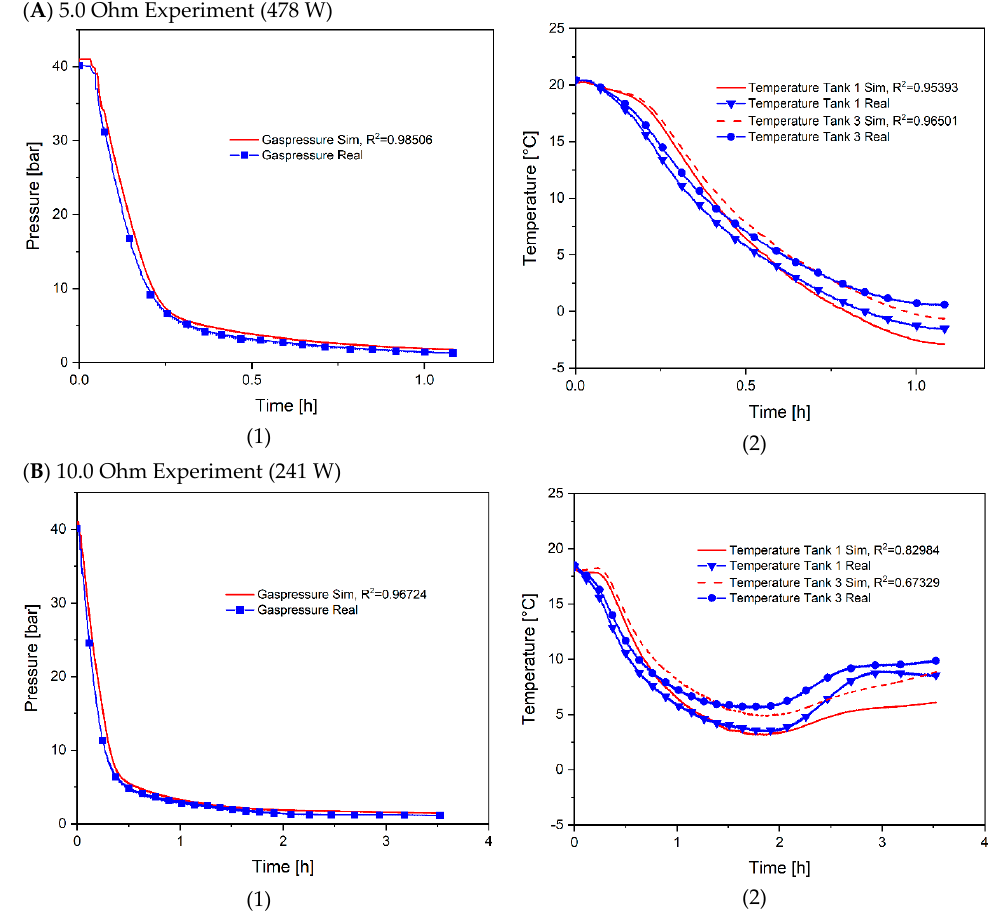
Figure 7. Simulated (Sim) and measured (Real) system pressure curves (1) and temperature curves of tanks 1 and 3 (2) at different condictions: ( A ) 5.0 Ohm and ( B ) 10.0 Ohm experiments. For the scenario under a constant resistance of 5.0 Ohm (Figure 7(A1)), the pressure curve starts at 40 bar and decreases, due to the baseline consumption of the fuel cell of about 5 NL/min (see Figure 6a) within 0.23 h to 6.23 bar. Subsequently, the slope of the curve drops sharply, so that by the end of the experiment, only a pressure decrease of 5.15 bar to the nearly ambient pressure of 1.08 bar occurs during 1.2 h, while a total amount of hydrogen of about 0.4 wt.% H 2 was desorbed.